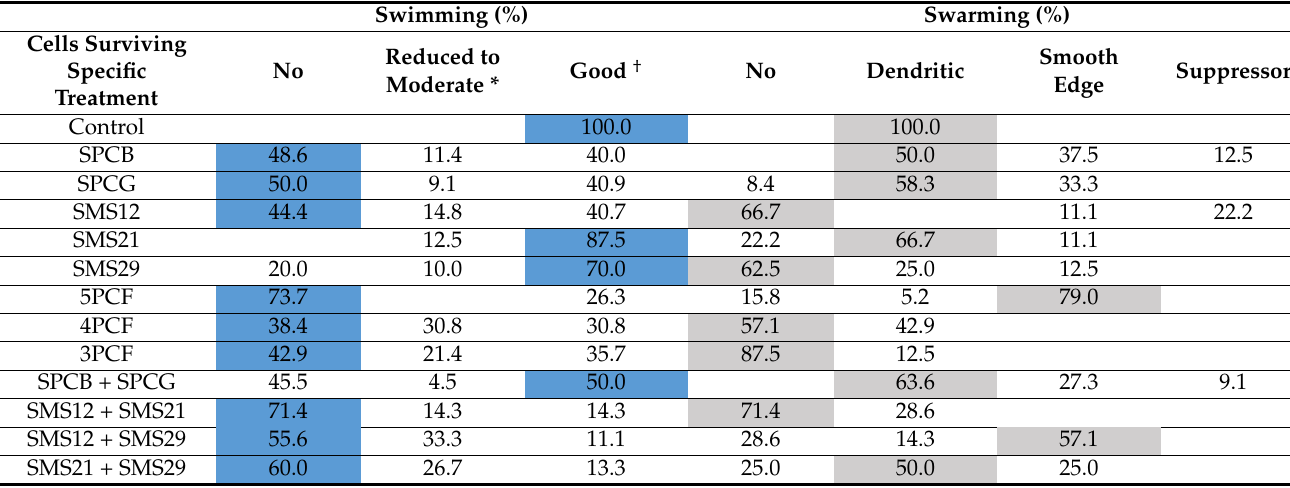
Table 4. Swimming and swarming motilities of P. aeruginosa cells surviving 24 h of treatment with different phage formulations.